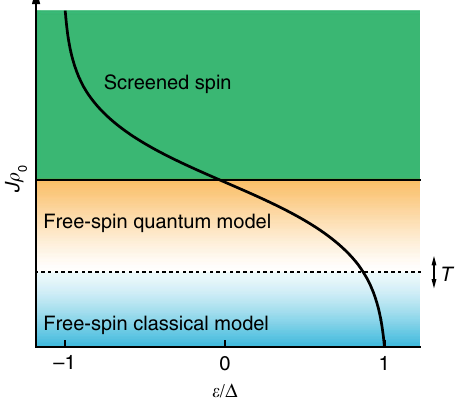
Fig. 5 Sketch of the YSR phase diagram. The transition from a classical spin model to a quantum description depends on the